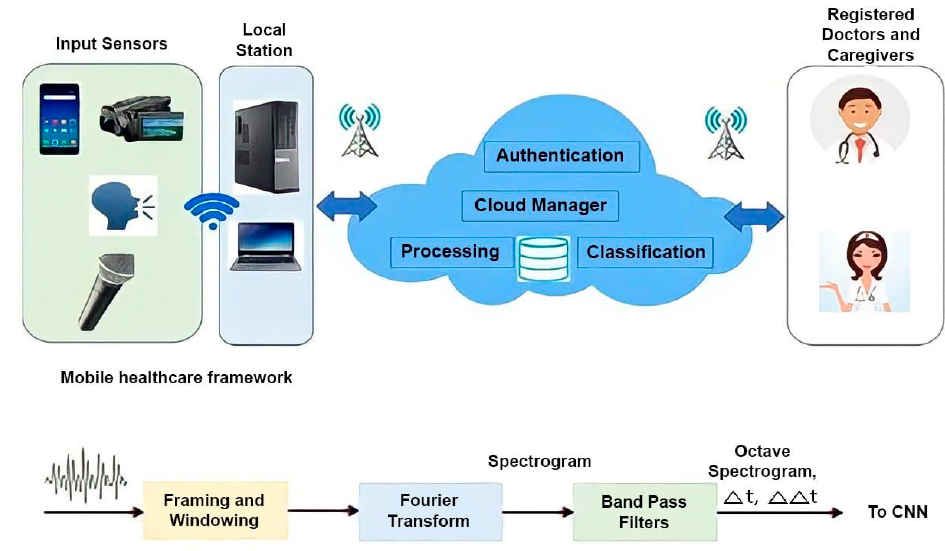
Figure 10. The proposed remote healthcare framework in.